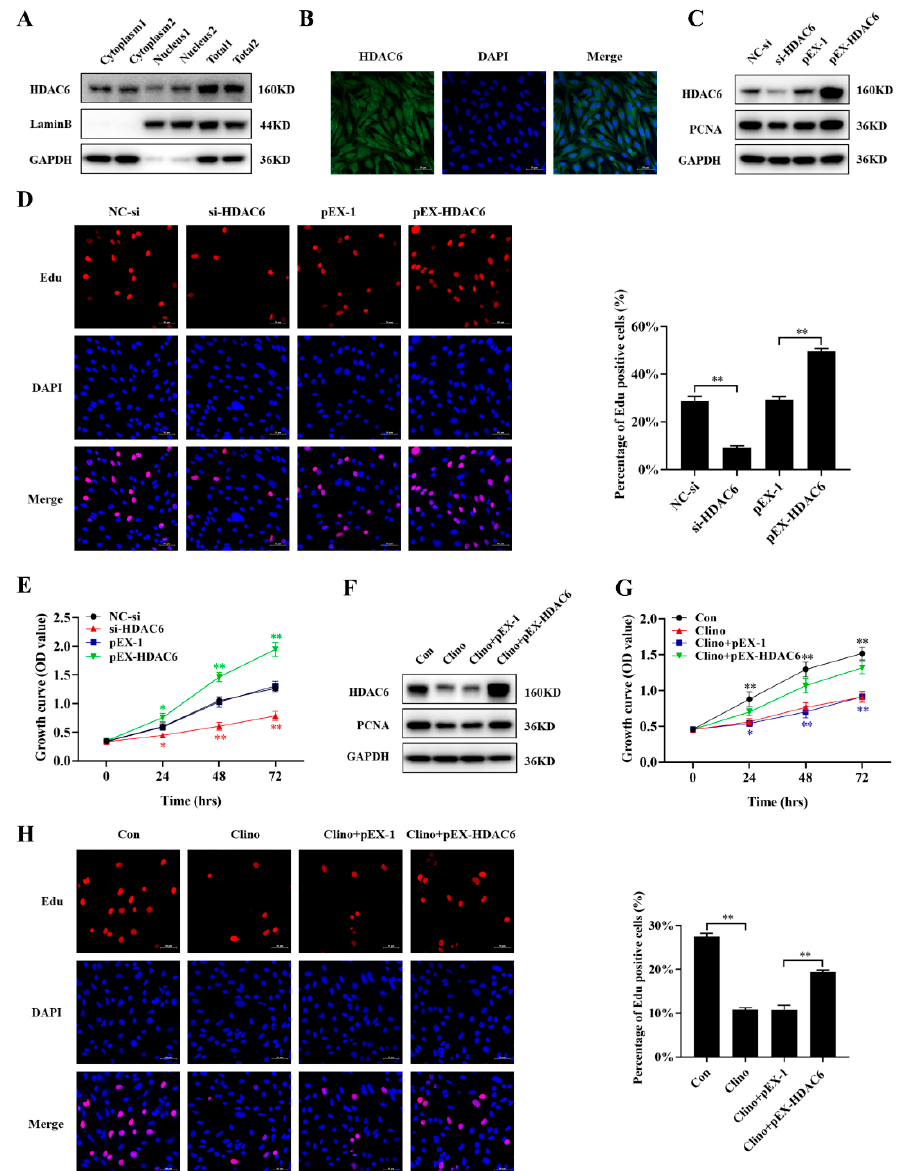
Figure 2. HDAC6 promotes microvascular endothelial cell proliferation and attenuates the inhibition of cell proliferation caused by clinorotation unloading. ( A ) The localization of HDAC6 was examined by Western blotting. ( B ) The localization of HDAC6 was examined by immunofluorescence staining. ( C ) The HDAC6 and PCNA protein levels in microvascular endothelial cells were analyzed by Western blotting after transfection with HDAC6 siRNA or pEX-HDAC6 (N = 3). ( D ) The EdU incorporation assay was analyzed by confocal microscopy (N = 3). ( E ) Cell proliferation was evaluated by CCK-8 assay (N = 3). The symbol *(Red) represents the NC-si vs. si-HDAC6 group; the symbol *(Green) represents the pEX vs. pEX-HDAC6 group. ( F ) The protein expression of HDAC6 and PCNA was analyzed by Western blotting after microvascular endothelial cells were transfected with pEX-HDAC6 and then cultured under mechanical unloading conditions for 48 h (N = 3). ( G ) Cell proliferation was evaluated by CCK-8 assay (N = 3). The symbol *(Black) represents the Con vs. Clino group; the symbol *(Blue) represents the Clino plus pEX vs. Clino plus pEX-HDAC6 group. ( H ) The EdU incorporation assay was analyzed by confocal microscopy (N = 3). Scale bar, 50 µ m. * p < 0.05, ** p < 0.01 vs.